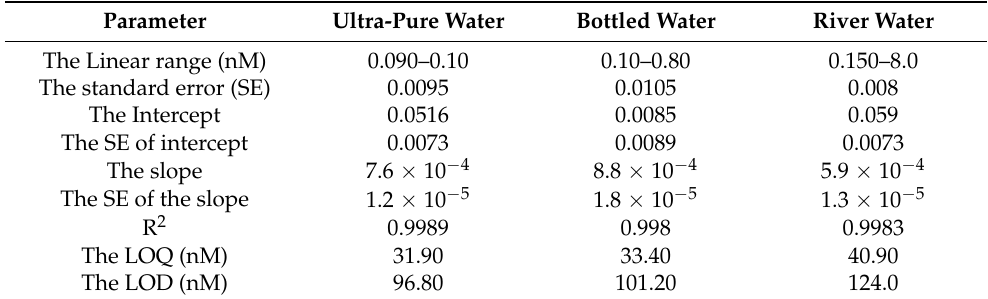
Table 1. Analytical parameters and LOD values for the determination of Hg 2+ by the colourimetric sensor. Parameter Ultra-Pure Water Bottled Water River Water The Linear range